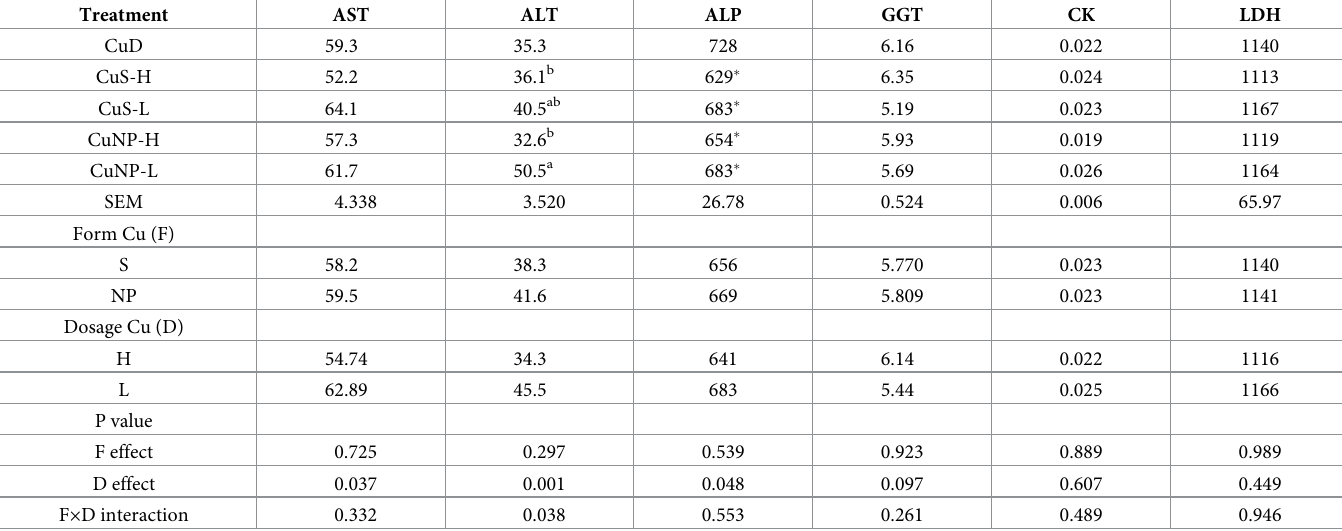
Table 8. Activity of selected enzymes in plasma of rats fed experimental diets (U/l).